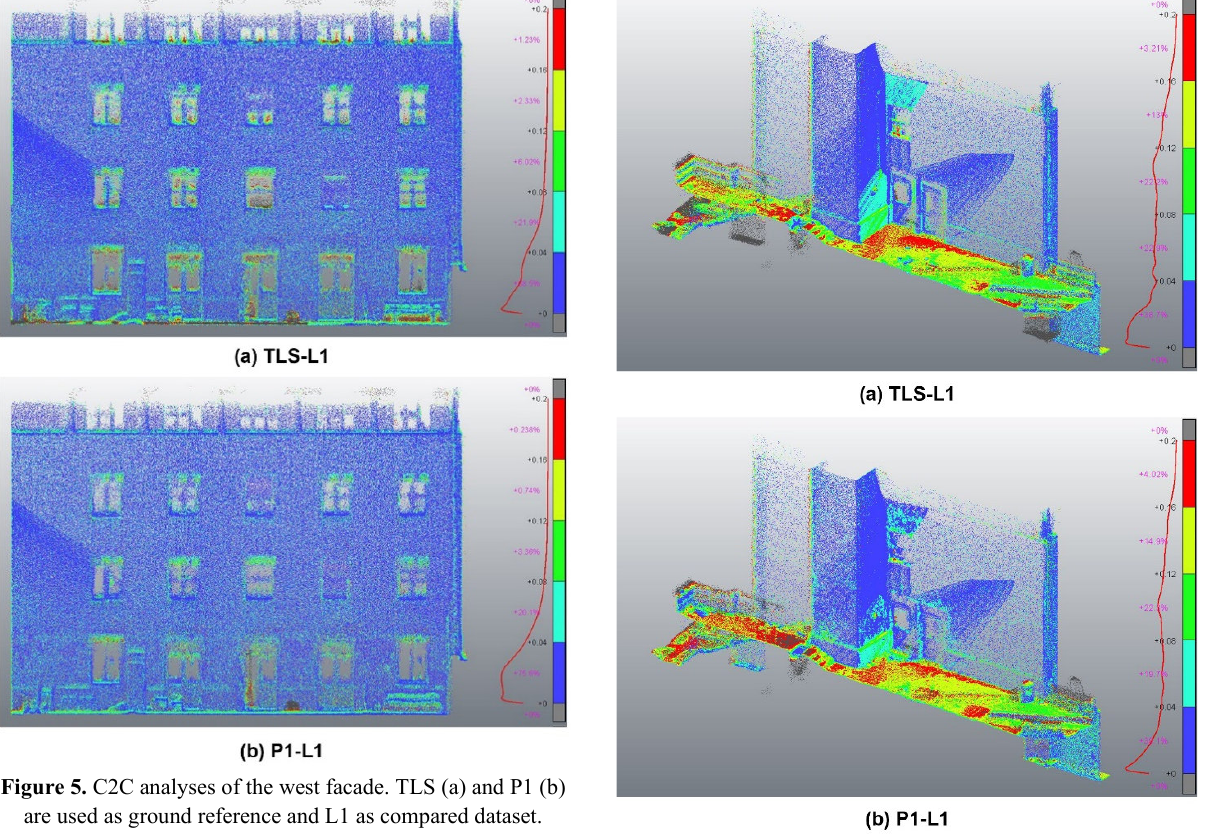
Figure 6. C2C analyses of the north façade. TLS (a) and P1 (b) are used as ground reference and L1 as compared